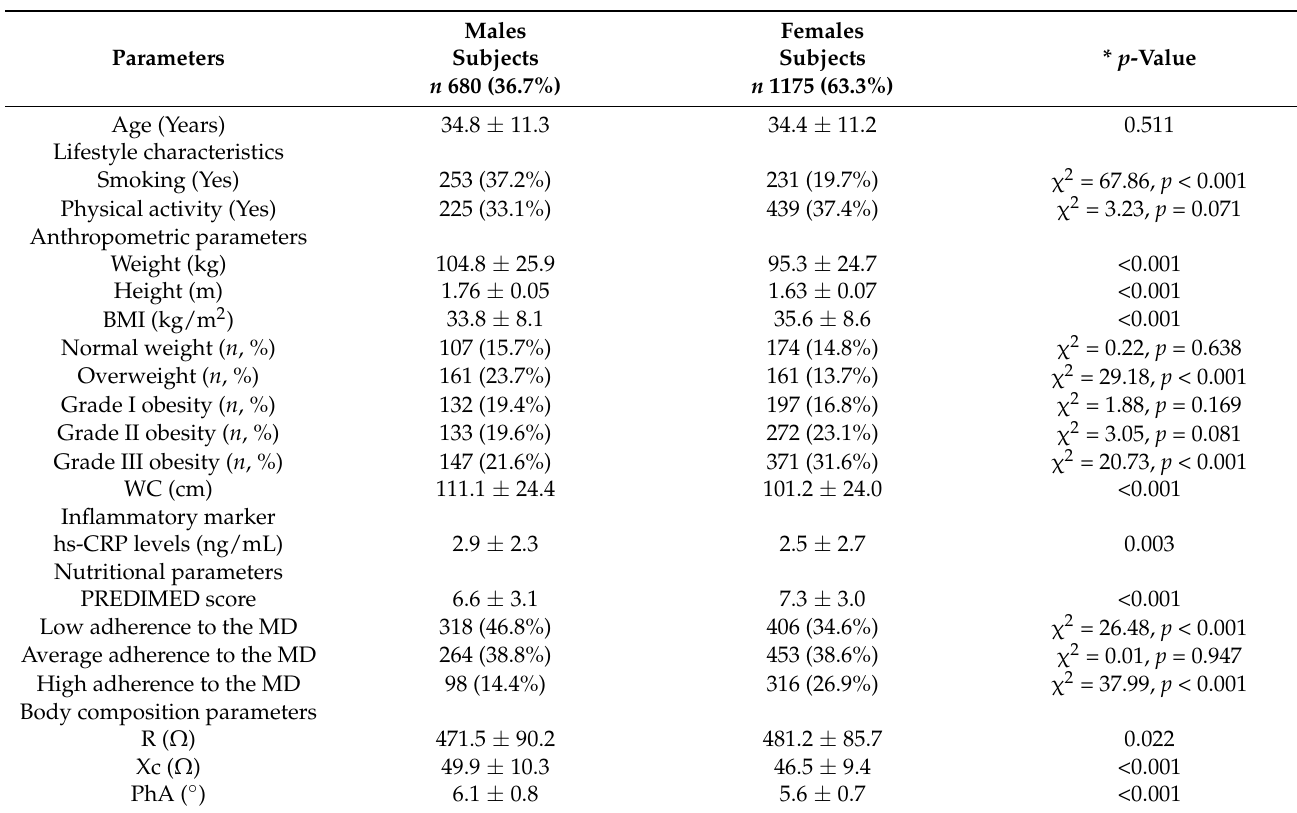
Table 1. Differences in study parameters between males and